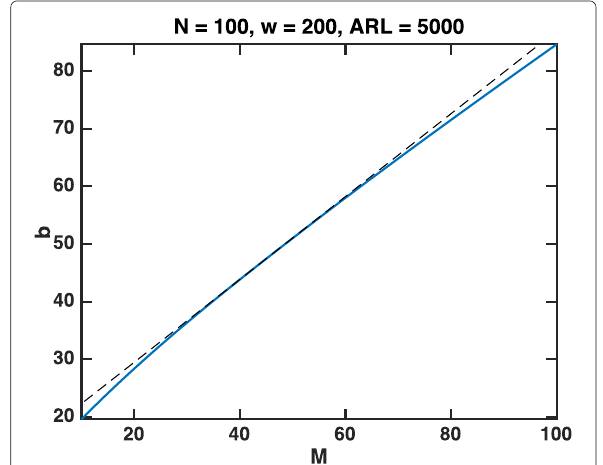
Fig. 1 For a fixed ARL being 5000, the threshold b versus M obtained using Theorem 1, when N = 100 and w = 200. The dashed line corresponds to a tangent line of the curve at one